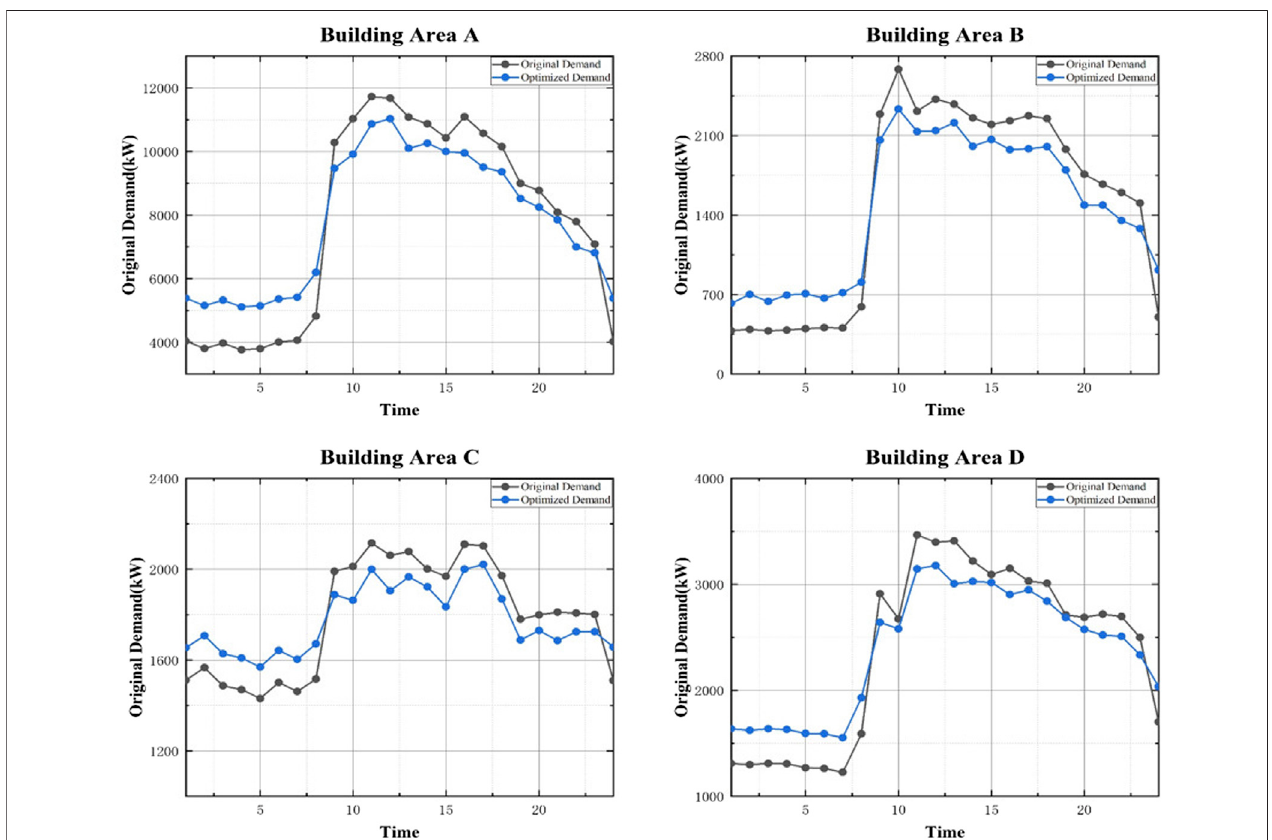
FIGURE 7 | Optimized demand pro fi les of four campus accounts on the test day of active storage buildings.